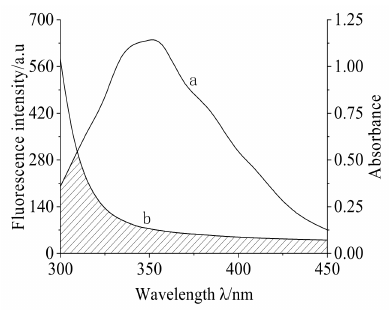
Figure 4. The overlapping spectra (a) of TRP fluorescence emission spectra and UV absorption spectra (b) of MC. C (TRP) = 3 × 10 − 6 mol/L; C (MC) = 3 × 10 − 6 mol/L; pH = 7.4; T = 298